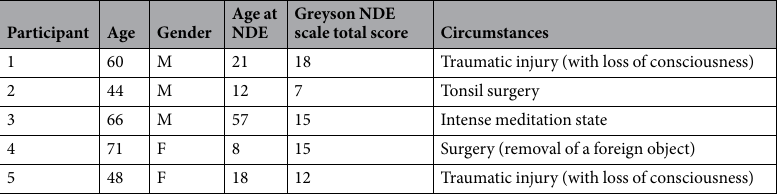
Table 2. Participants’ descriptive and clinical